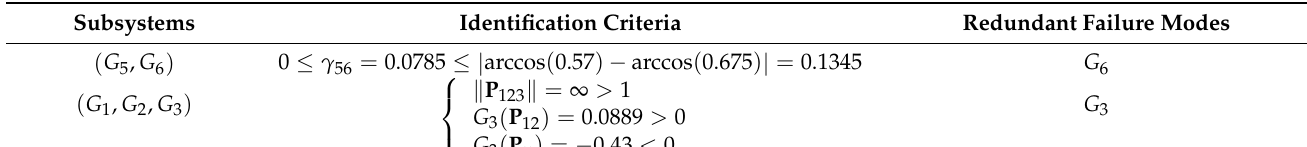
Figure 5. Six failure modes for numerical example 1. Table 2. Identification criteria and redundant failure modes for numerical example 1.